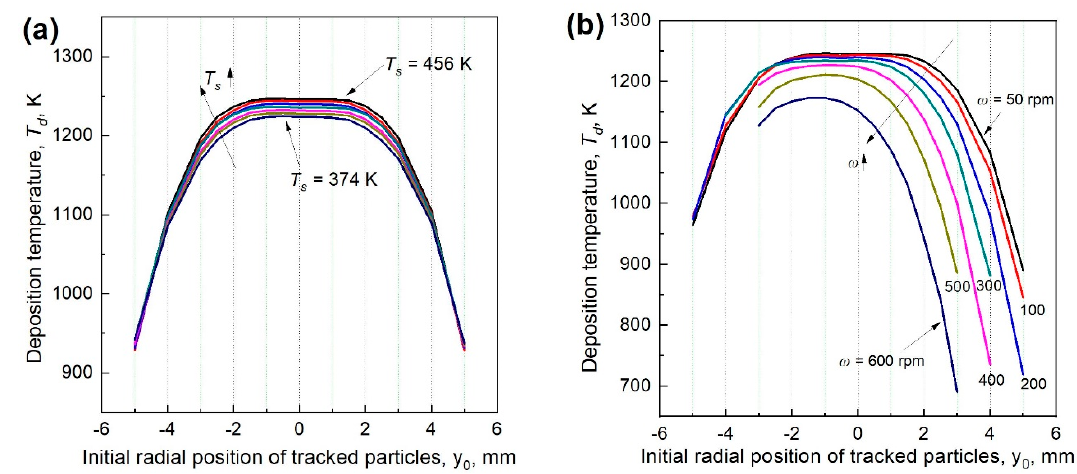
Figure 11. Deposition temperature of the tracked particles when the stagnation surface is ( a ) in stationary and ( b ) rotates at different speeds.